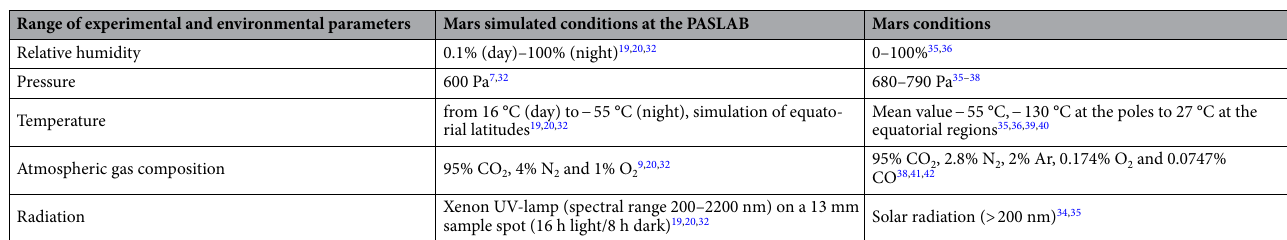
Table 1. Experimental conditions used at the PASLAB of the DLR Institute of Planetary Research in Berlin compared to Mars surface conditions.